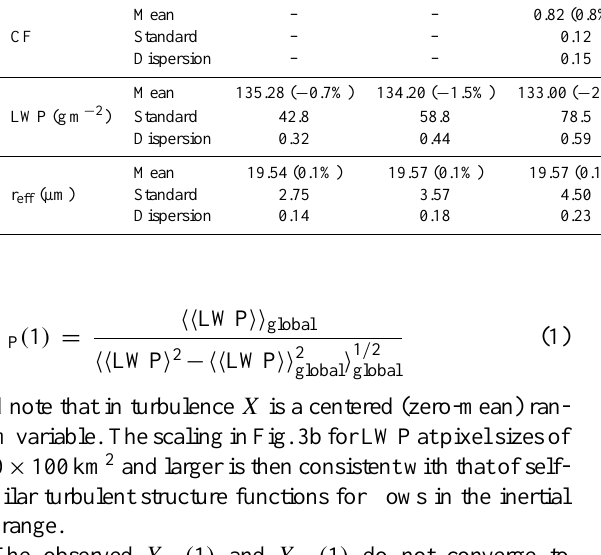
Fig. 3. Scale dependence of the global mean (red), global standard deviations (blue), and mean rescaled over the global standard deviation (green) for CF, LWP and r eff . The double brackets << · · · >> stand for ‘global/ensemble average of local means (at a specific scale).’ The primed quantities on the green y-axis refer to deviations from the global average value. Table 1. Observed means, standard deviations and dispersions (inverse of the normalized means) in the panels of Fig. 3. Parentheses show the %-difference of every mean from the mean of all means, i.e., the global average.